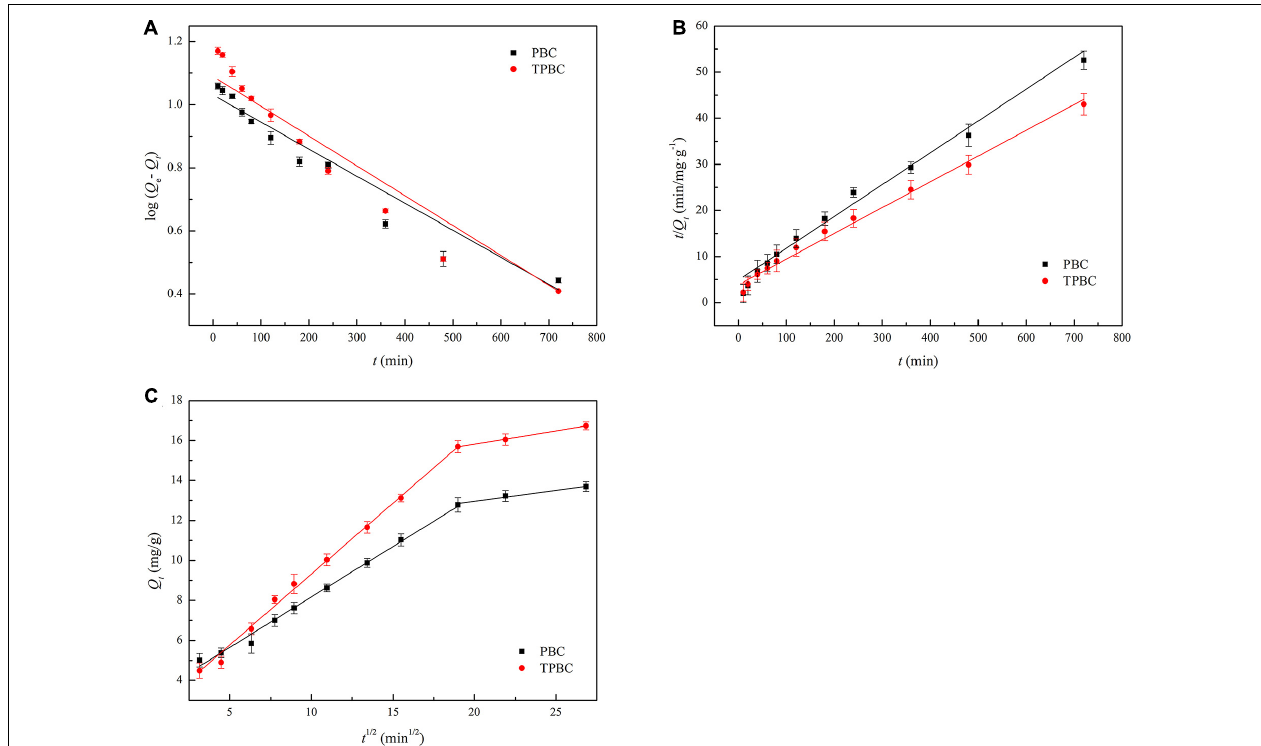
FIGURE 5 | Kinetic modeling of TC adsorption on the surface of the biochars using the pseudo-first-order (A) pseudo-second-order (B) , and intraparticle diffusion (C) models.